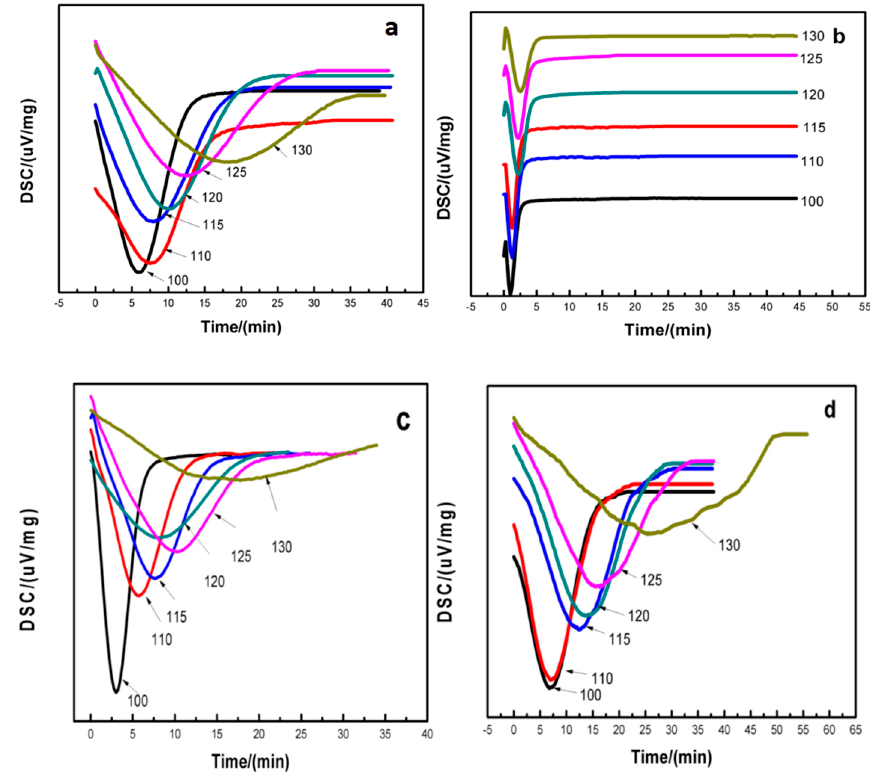
Figure 8. DSC curves of ( a ) pure PLLA, ( b ) PLLA0.5, ( c ) PLLA1.0, and ( d ) PLLA1.5 in the temperature range from 100 to 130 °C, respectively.